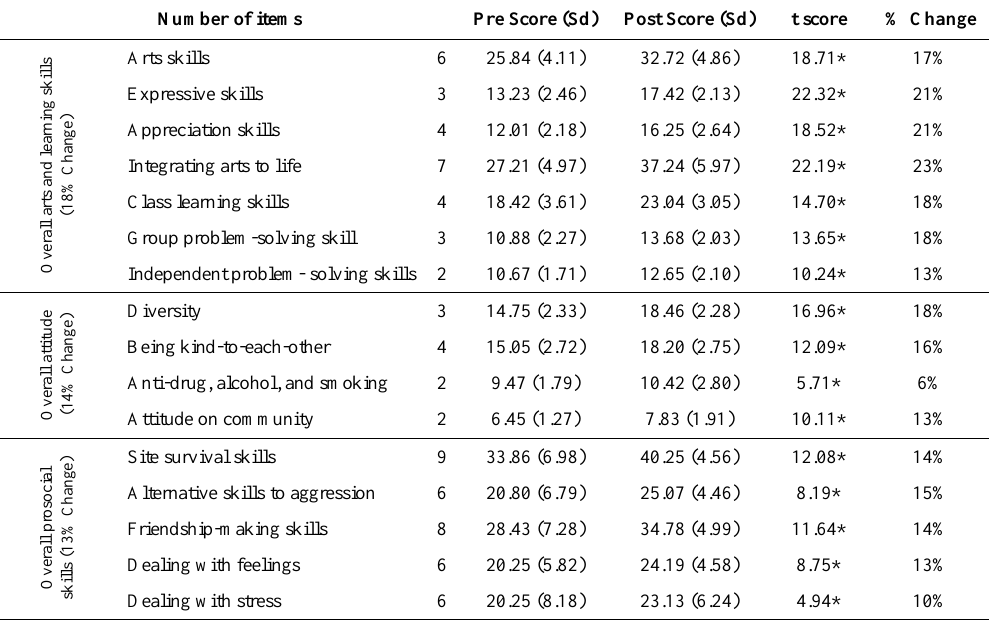
Table 2. Children’s Skills and Attitude Development (N=191)